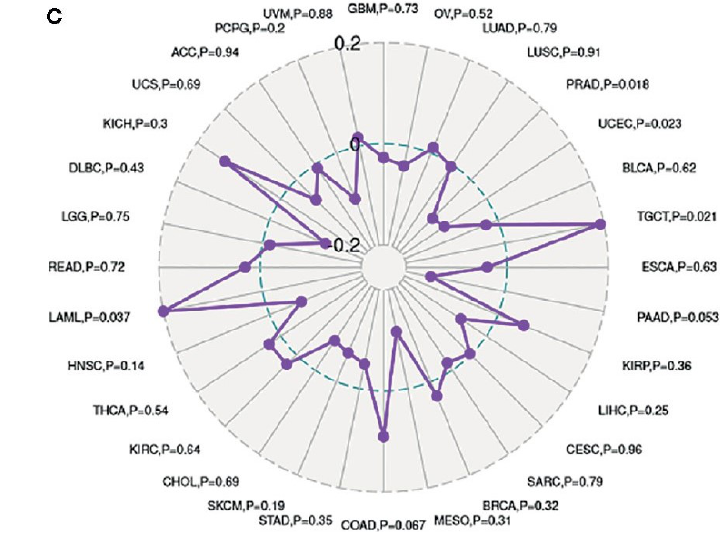
Figure 19. Circular coordinate system [70]. Radar map of correlation between LCN2 expression and MSI.